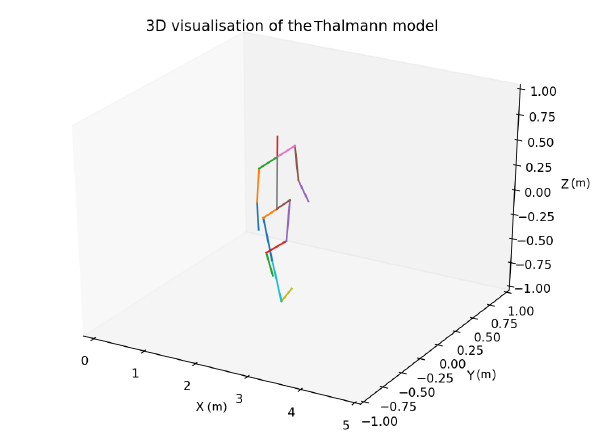
Figure 2. In this visualisation of the Thalmann model, the various body parts that are modelled can be seen, indicated by different colors.